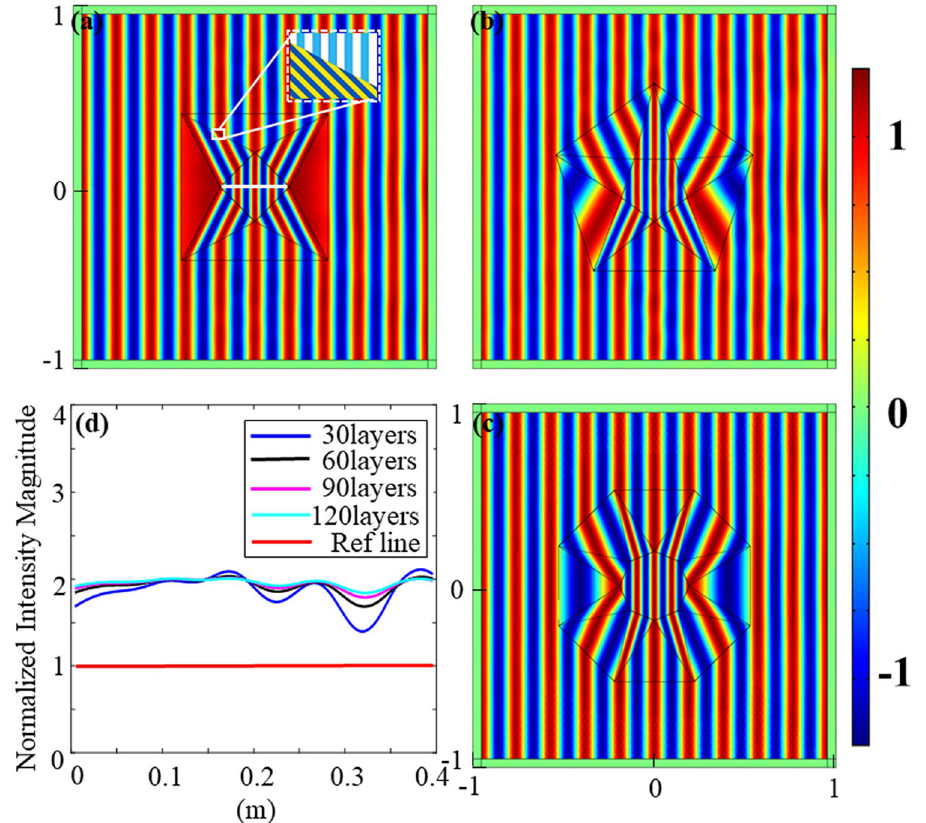
Figure 4. ( a – c ) Pressure field distributions of different regular polygons. ( a ) Square concentrator; ( b ) pentagonal concentrator; ( c ) octagonal concentrator; ( d ) normalized intensity magnitude in central area of ( a ). The values are taken from the straight line segments of y = 0 m and x = − 0.2 ∼ 0.2 m . The line is located in the central area, as shown by the white line segment in ( a ). The Ref line is reference line in the same position, but without the device. Curves in different colors represent the pressure fields of different